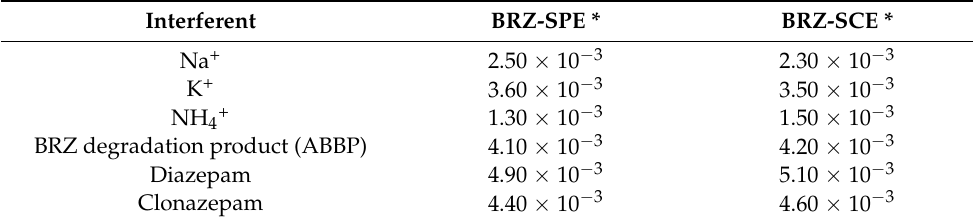
Table 2. Potentiometric selectivity coefficients of the proposed bromazepam-selective sensors by the separate solution method using 1.0 × 10 − 3 M solutions of the interferent and BRZ at 25 ◦ C. Interferent